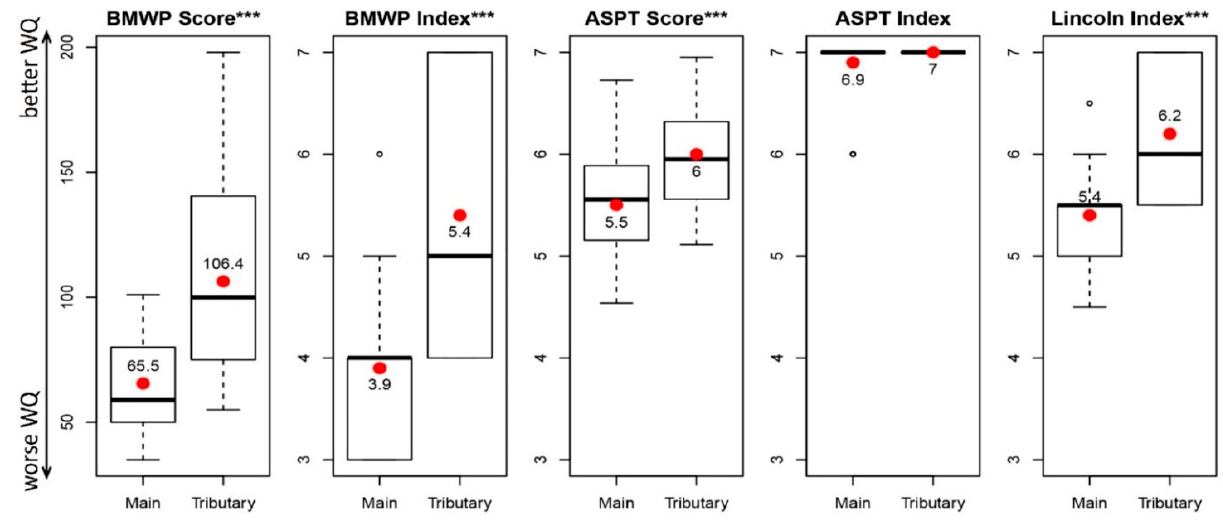
Figure 4. Biotic indices showing water quality between mainstem and tributary sites sampled in 2000s. Red dots indicate the mean values of each corresponding index. WQ: water quality. *** indicate statistically significant differences at p < 0.001.